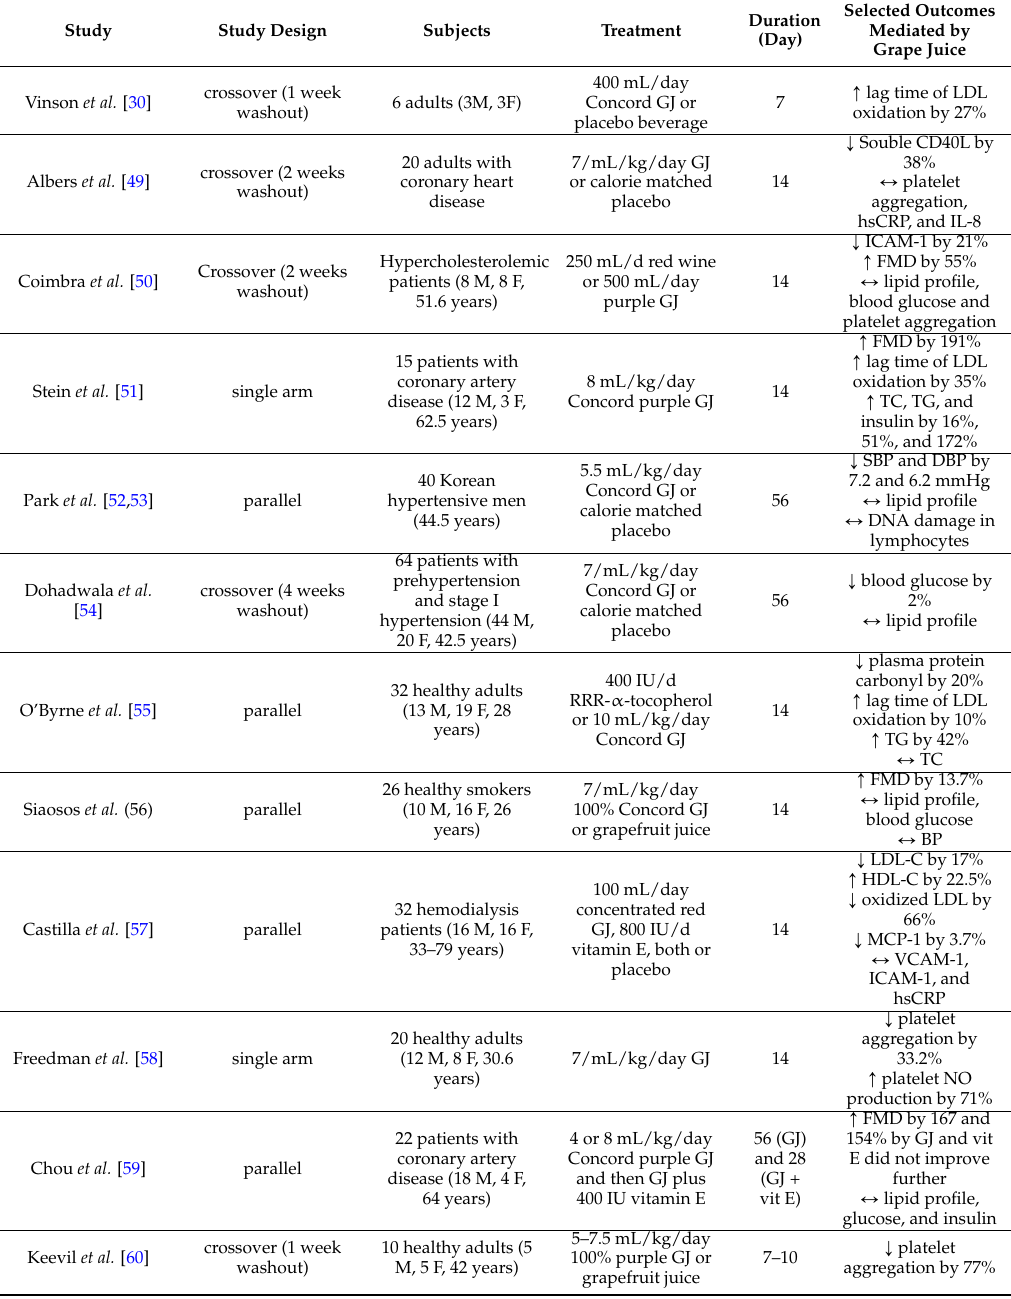
Table 2. Clinical evidence of grape juice on risk factors of cardiovascular